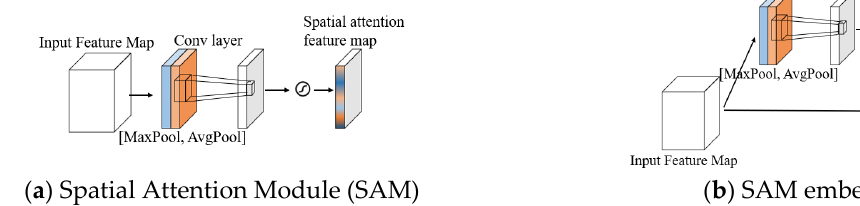
Figure 4. Spatial Attention Module and SAM module embedded in the neural network structure.